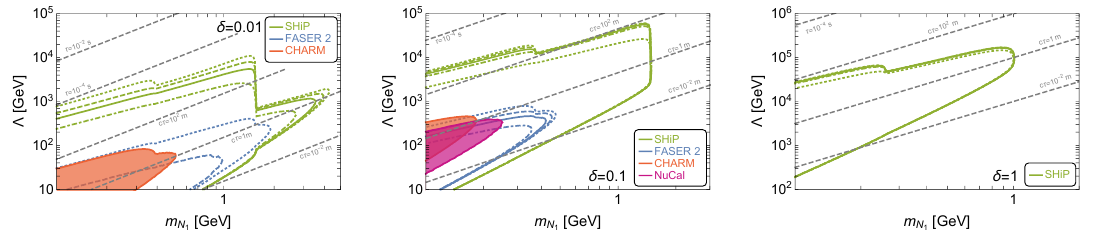
Figure 2 . Isocontours of N signal = 3 for SHiP (green lines) and FASER 2 (blue lines). For SHiP dotted, dashed, solid, dot-dashed and dotted lines are for E while for FASER 2 dotted, dashed, solid and dot-dashed lines are for E respectively. The CHARM and NuCal regions and the gray lines are as in figure 1. We fix α = π/ 2